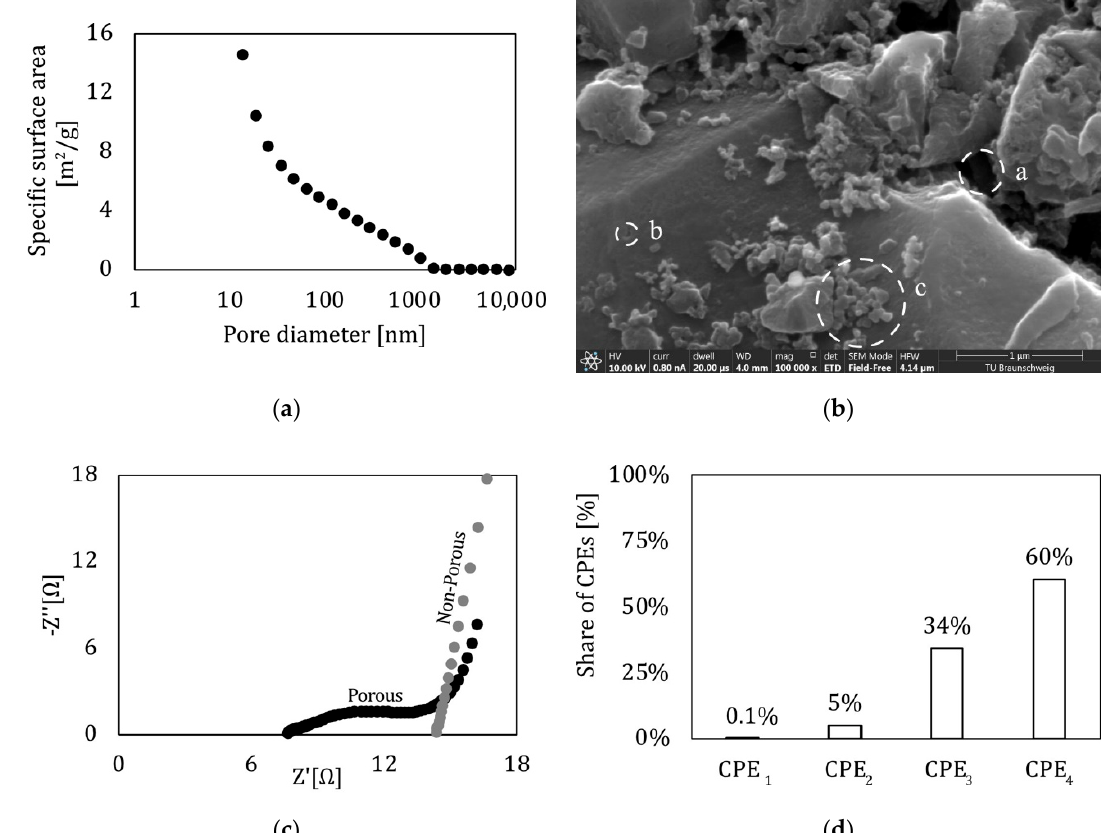
Figure 5. Analysis of the electrode material ( a ) Specific surface area of the electrode material by mercury porosimetry. ( b ) SEM image of the used electrode with different pore geometry and size. Three kinds of pores are identified. (a) big ‐ sized secondary pores (b) small ‐ sized primary pores (c) small ‐ sized secondary pores. ( c ) Impedance spectra of two samples, one with an activated carbon electrode and one with a flat electrode made of aluminum. The porous network of the electrode is represented by the black semi circles (dashed ellipse), which are not present at the flat aluminum electrode. ( d ) Share of CPEs in the equivalent model.